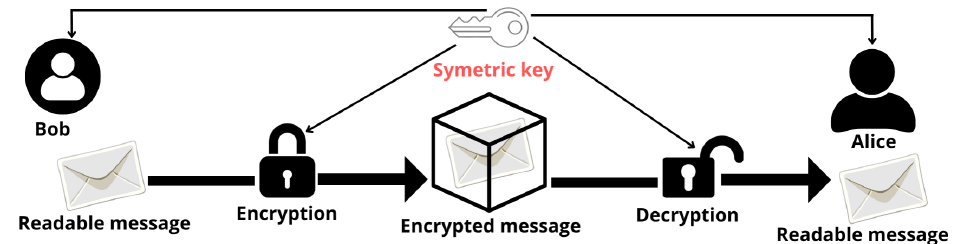
Figure 2. Symmetric key encryption.